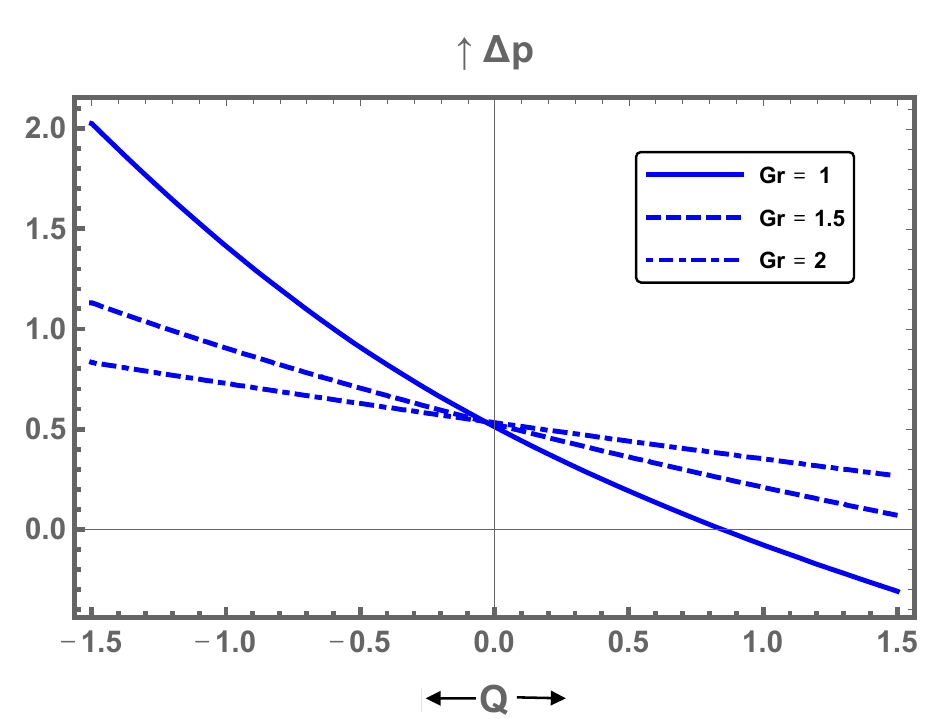
Figure 25. Display of pressure rise vs. volume flow rate for different values of Gr .